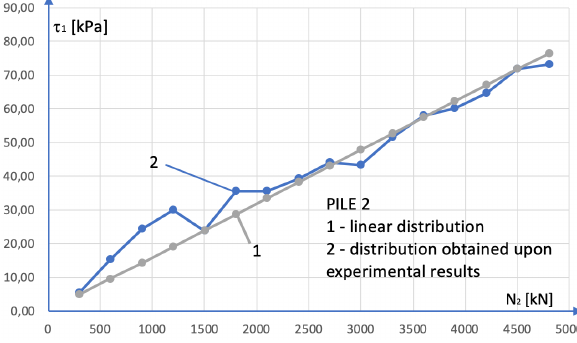
=6,89. 2 Figure 10b: Pile 2 values comparison; linear distribution for B